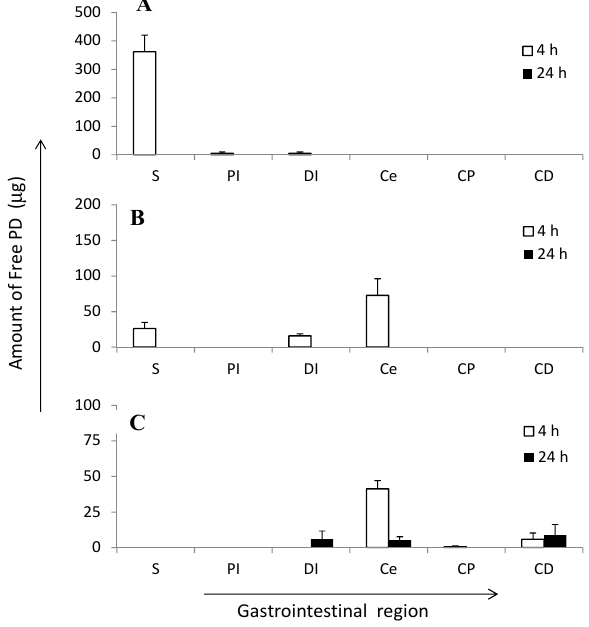
Figure 4. Distribution of free PD in gastrointestinal regions at 4 and 24 h after intra-gastric administration of ( A ) PD; ( B ) ES-MP and ( C ) Ch-MP/ES at 5 mg PD eq/kg in rats with TNBS-induced colitis. The results are described as the mean ± S.E. ( n = 3).